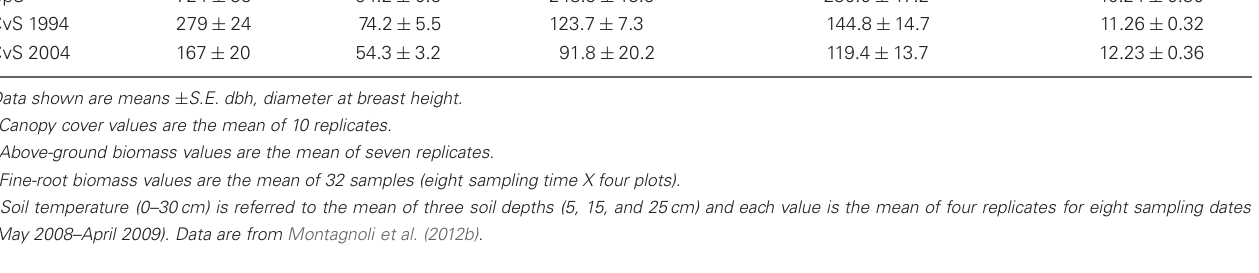
Table A1 | Beech above-ground characteristics, live fine-root biomass and soil temperature of the three investigated stands. Forest stand